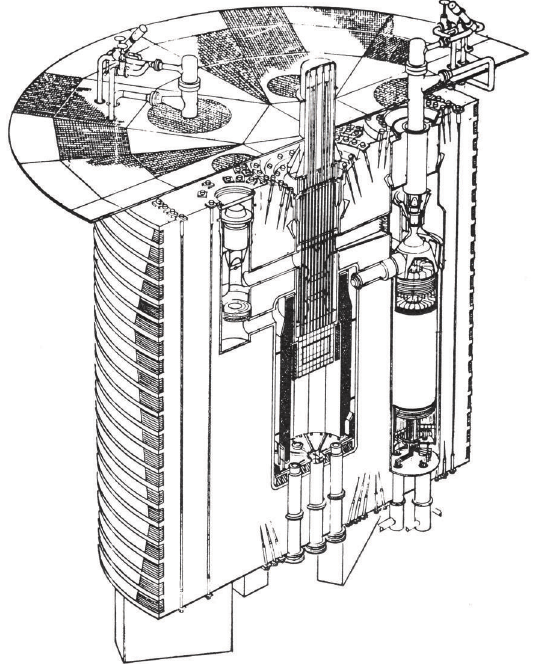
Figure 2: Primary system layout for the General Atomics GCFR Demonstration plant. The core cavity is shown empty. The overall system layout is typical for all gas-cooled reactor designs of the era. The large cavity on the right side of the core contains a boiler and a blower. The smaller cavity on the left side houses one of the active DHR systems. Figure reproduced from [4].